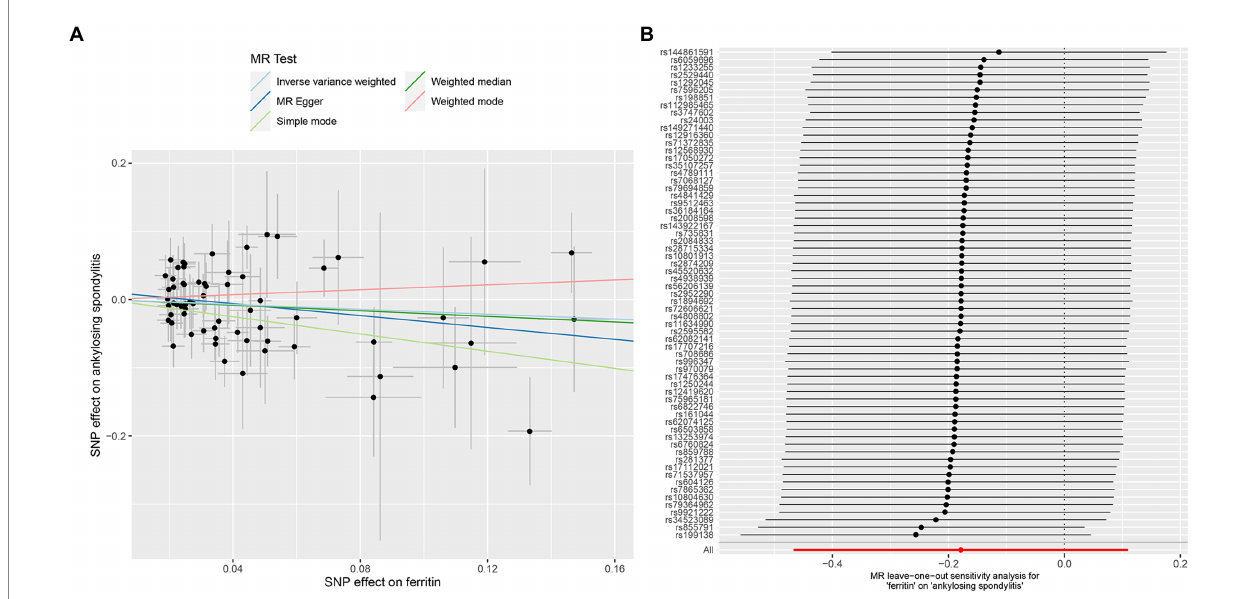
FIGURE 2 MR analysis of the ferritin and ankylosing spondylitis. (A) Scatter plot. (B) Leave one out